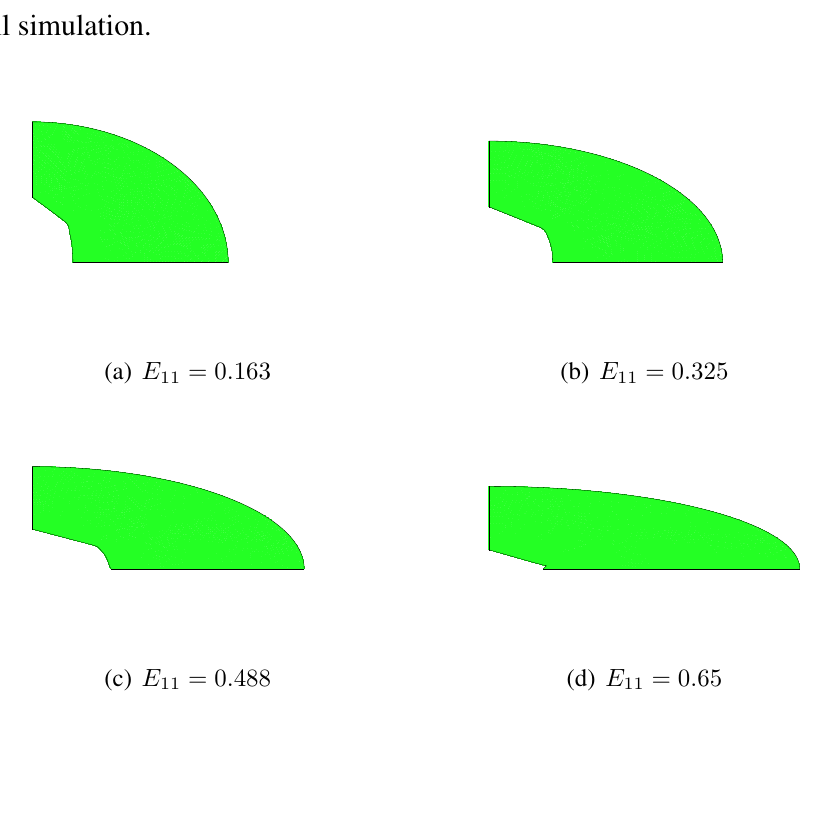
= − 0 . 5 , as obtained with ε